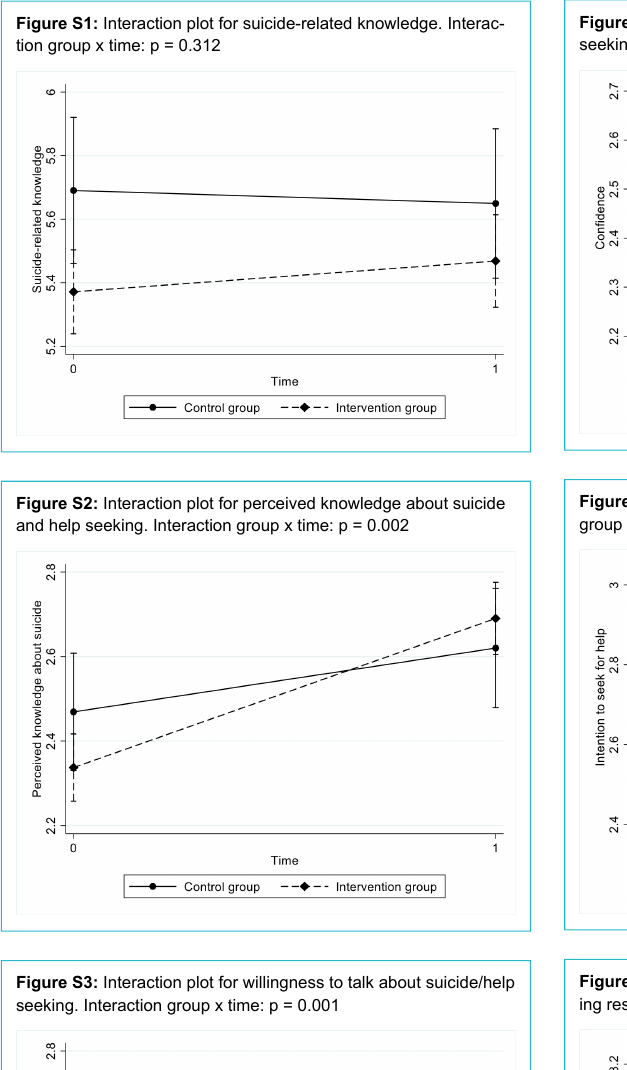
Figure S3: Interaction plot for willingness to talk about suicide/help seeking. Interaction group x time: p = 0.001